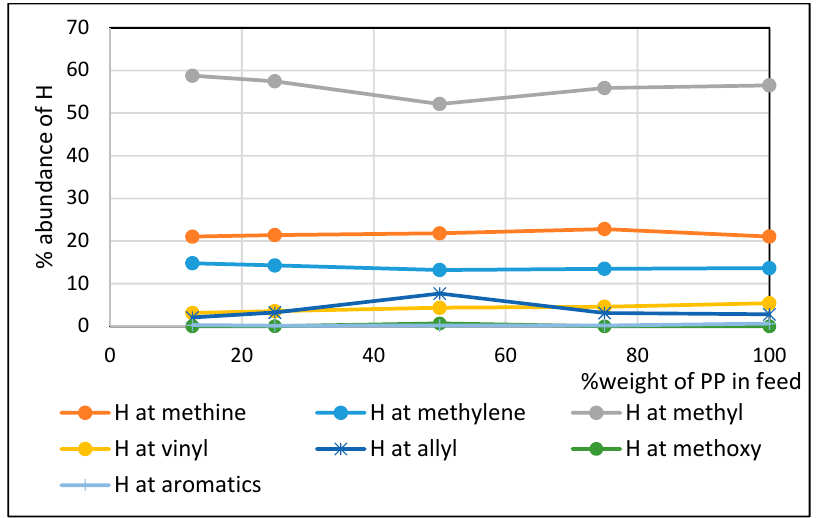
Figure 12. H-NMR analysis of wax.